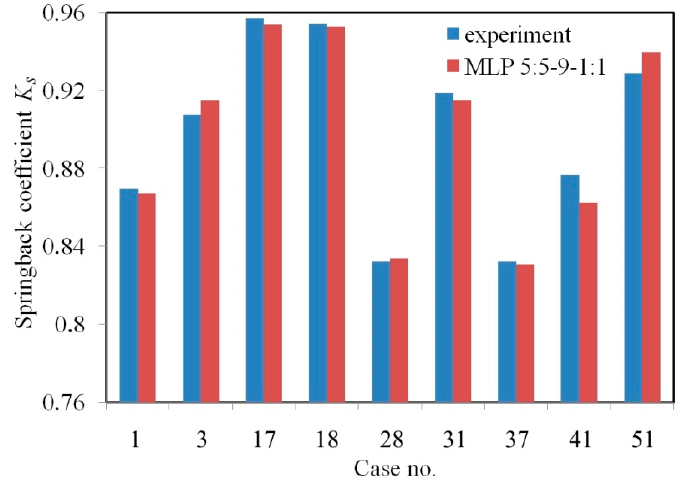
Figure 8. Comparison of the prognostic capacity of the MLP 5:5-9-1:1 trained using the Quasi-Newton (QN) algorithm with the experimental values of springback coefficient K s . Table 5. Quantitative comparison of the springback coefficients Ks determined experimentally and by MLP 5:5-9-1:1.